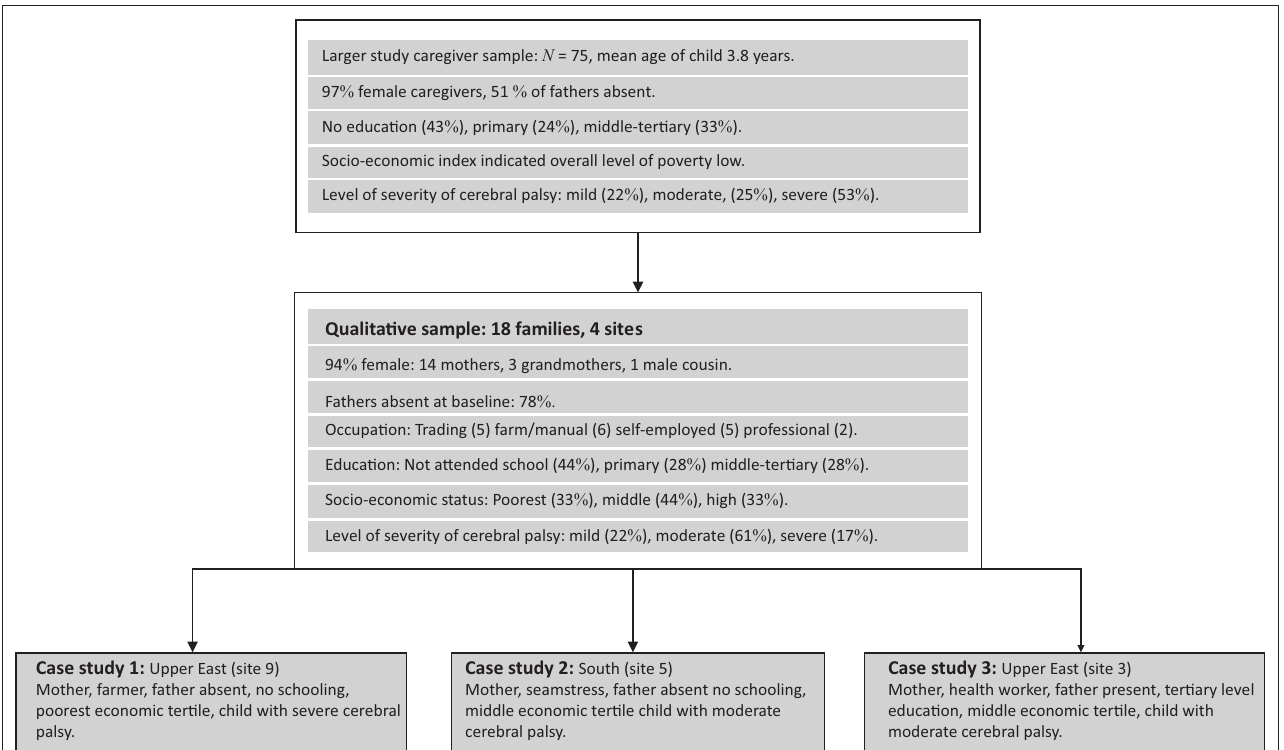
FIGURE 1: Details of sampling